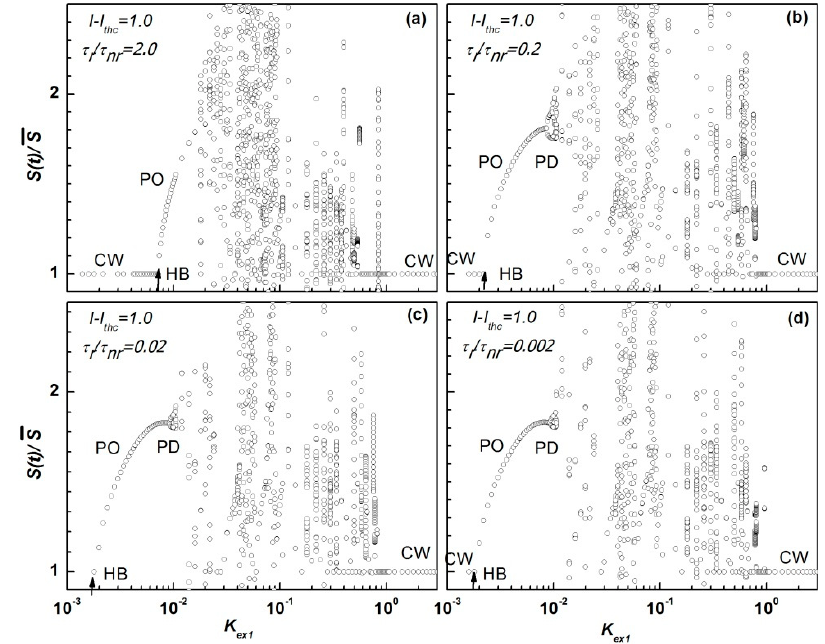
Figure 2. Operation states of an SL under OFB in terms of bifurcation diagrams, when ( I - I thc ) = 1.0 mA (near the threshold). ( a ) τ r / τ nr = 2.0, ( b ) τ r / τ nr = 0.2, ( c ) τ r / τ nr = 0.02, and ( d ) τ r / τ nr = 0.002.